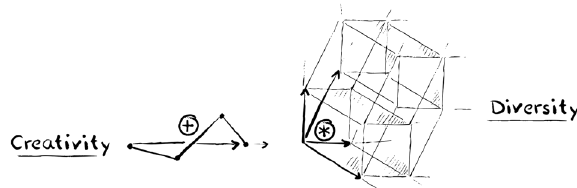
Fig. 8 + is for creativity, × is for diversity. Additions are linear operations. In geometry, additions extend things. They add line to line and create longer lines. By contrast, multiplications are used to express multidimensionality. They unite multiple lines, turning the lines into planes and spaces. The same distinction is found again in more advanced modeling. Additions